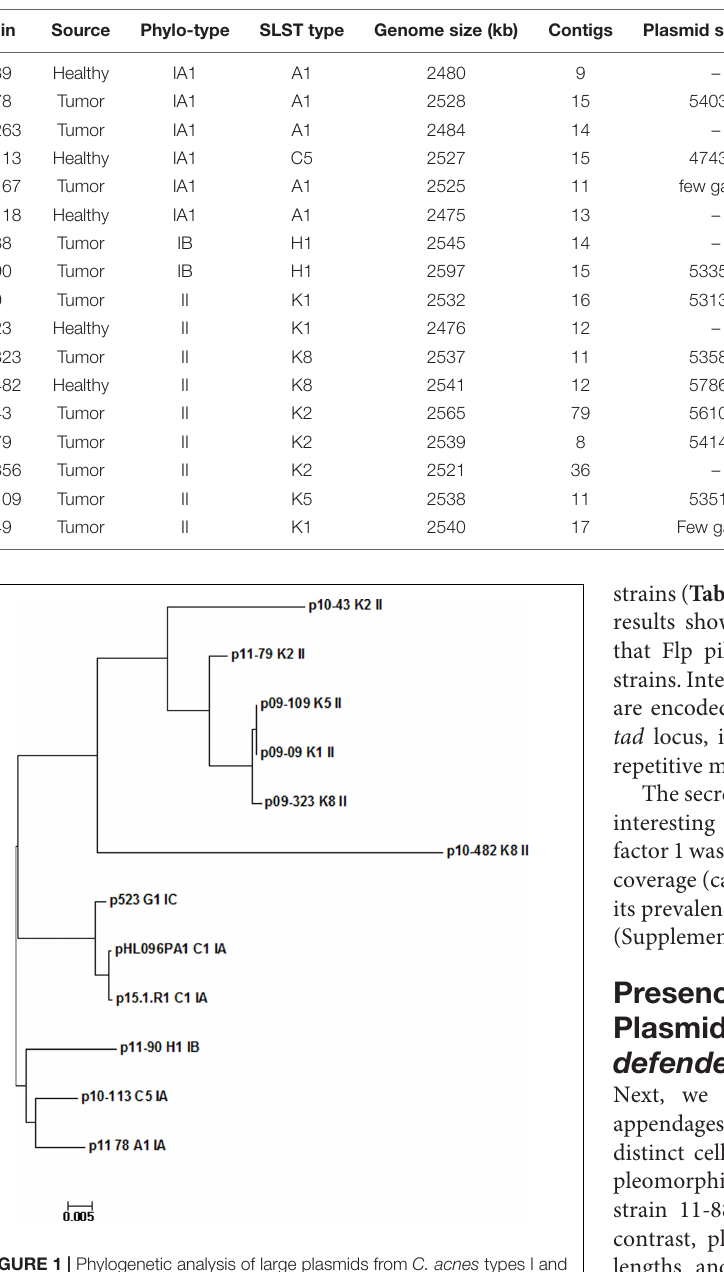
TABLE 3 | Features of sequenced C. acnes isolates and their large plasmids.